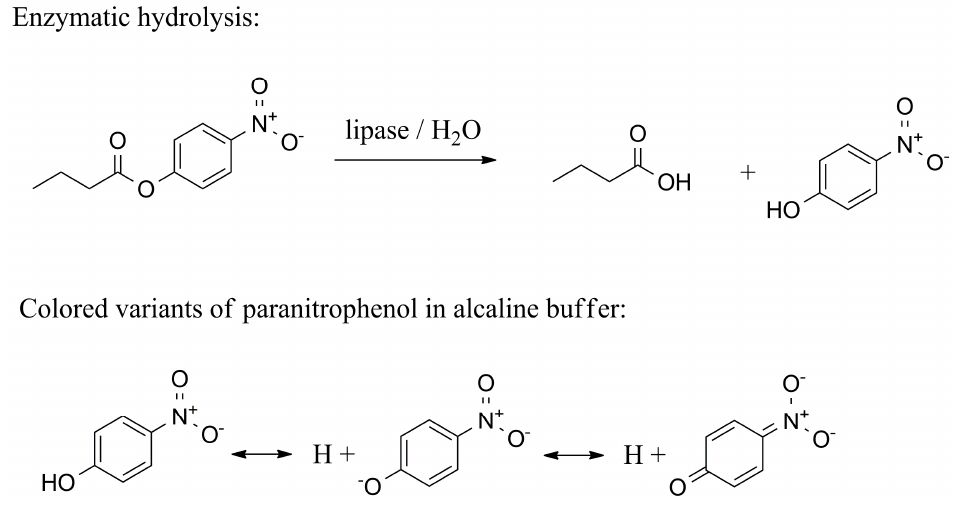
Figure 3. The lipase assay using p -nitrophenyl butyrate. The arising p -nitrophenol respective p -nitrophenolate absorbs light around 410 nm.